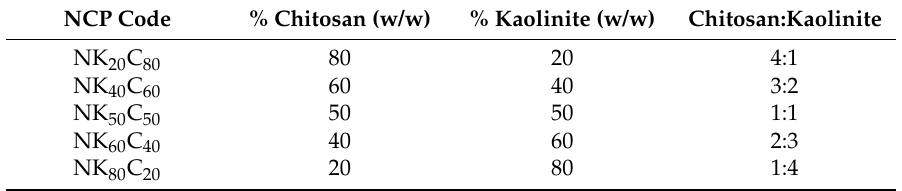
Table 1. Nanocomposites (NCPs) prepared from different proportions of chitosan and kaolinite. NCP Code % Chitosan (w/w) % Kaolinite (w/w)